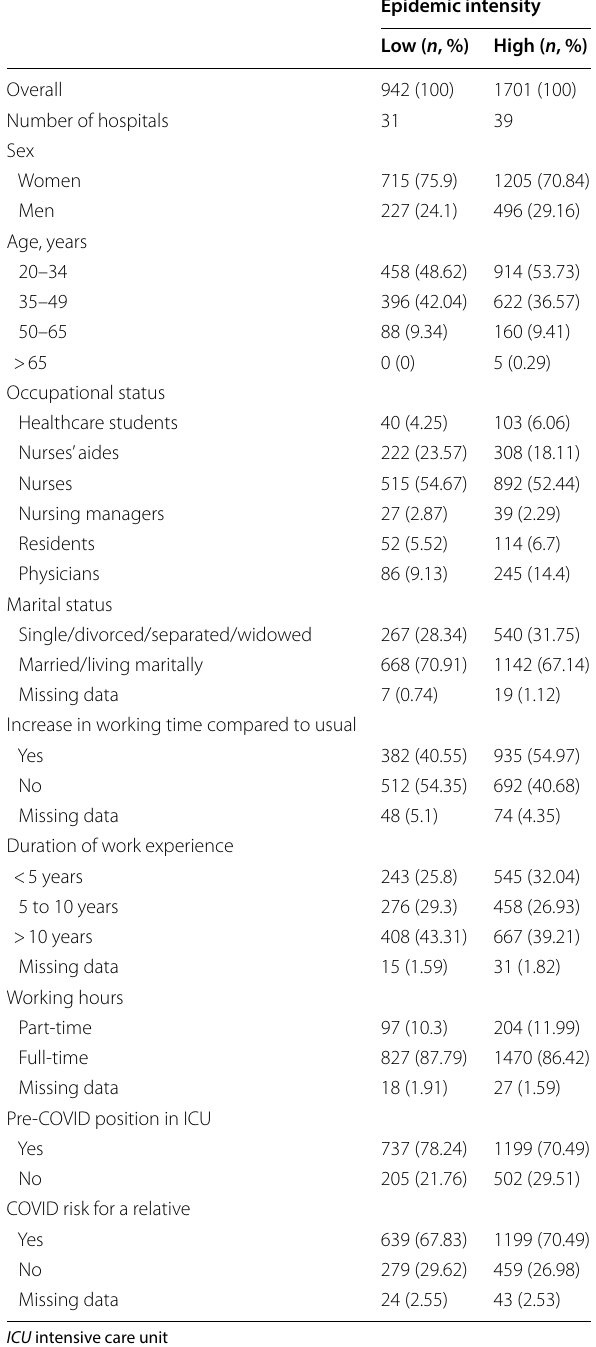
Table 1 Sociodemographic data of the overall population and according to epidemic intensity zone